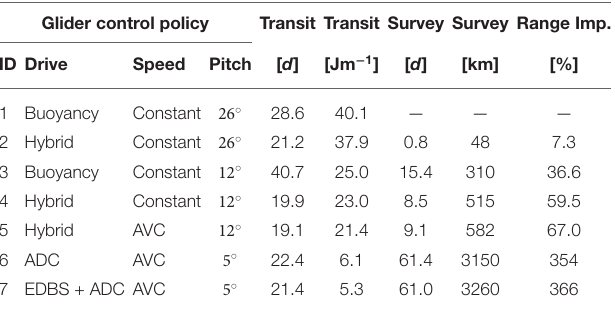
TABLE 3 | Performance analysis of seven different glider control policies applied to a hypothetical sea-ice survey at the Chukchi Plateau. Glider control policy Transit Transit Survey Survey Range